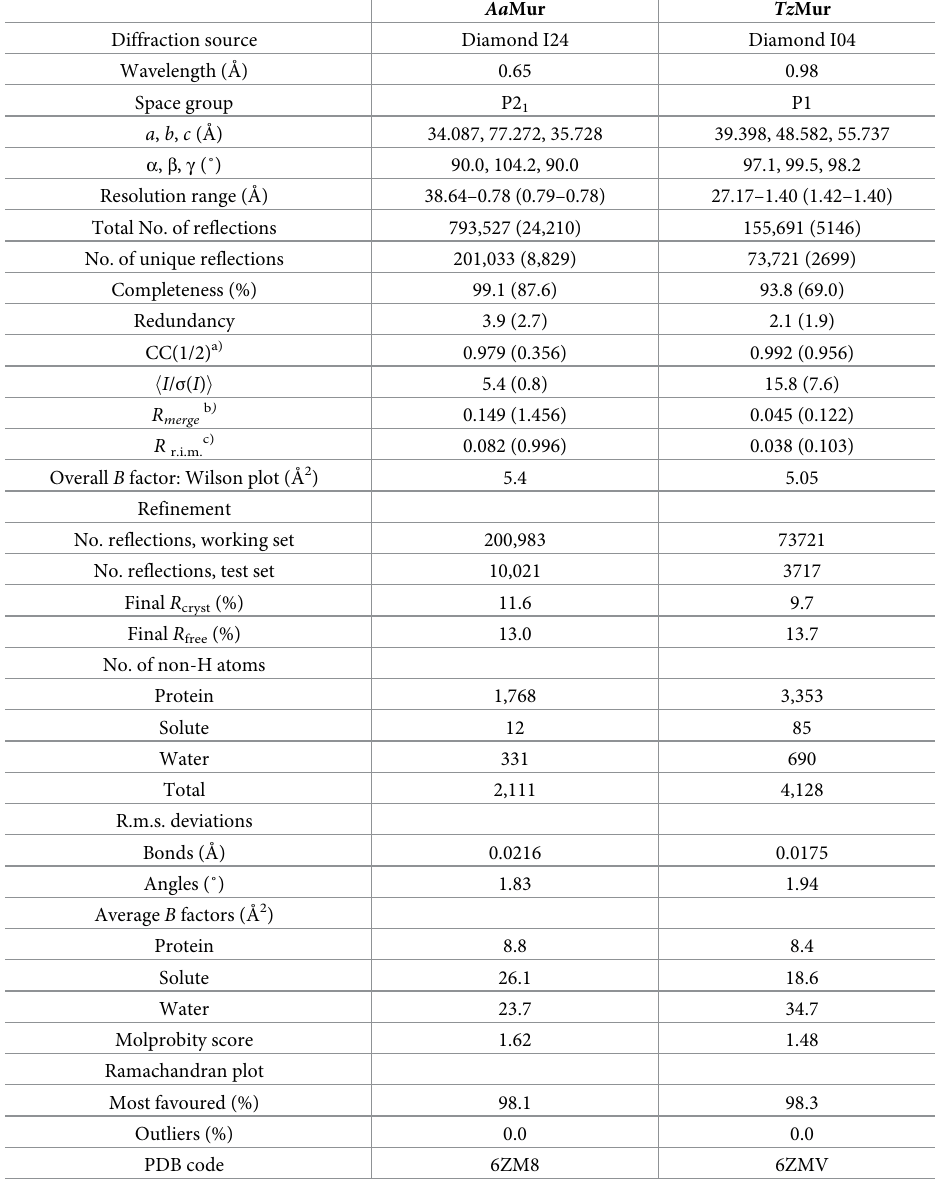
Table 2. Crystallographic statistics. Values in parentheses are for the outer resolution